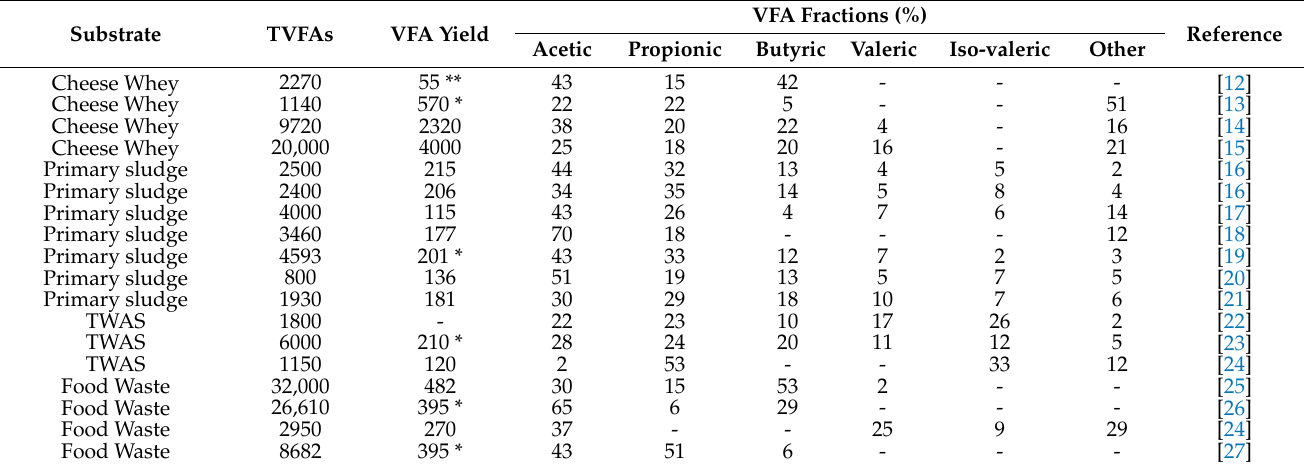
Table 1. Literature studies on the total volatile fatty acids (TVFAs) concentration, yield, and fractions produced from the anaerobic fermentation of food